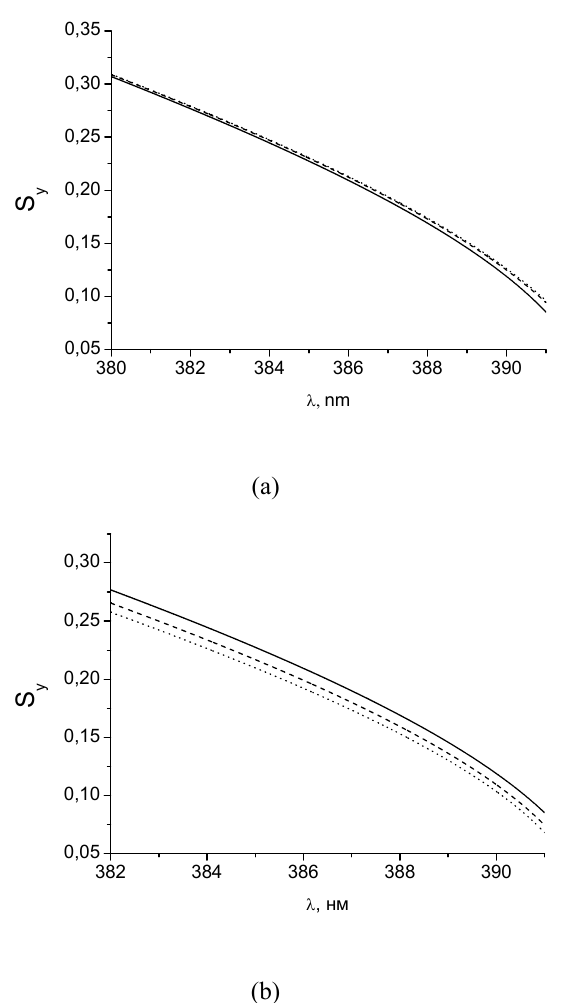
Figure 10: Spectral dependence of the expected value of transverse spin (in ħ units per photon) for the plasmon- polariton formed at interface of the metal-dielectric multilayered Ti O /Ag structure and a dielectric: а ) water 3 5 =ε ); b) water (solid line), glyserine ( 769.1 1 =ε ) (dashed line), optical glass BAF 10 ( 170.2 1 =ε ) (dotted line). The optical axis is oriented at ( 753.2 1 the angle: а ) θ =87.8 о (solid line), 89 о (dashed line), 90 о (dotted line); b) 87.8 о .